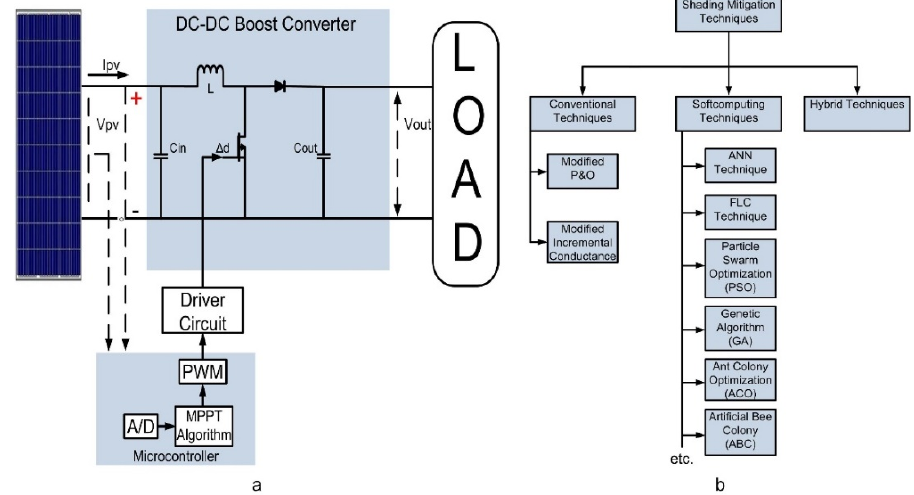
Figure 1. Solar photovoltaic system with MPPT algorithms ( a ) Basic block diagram of PV system. ( b ) Various MPPT algorithms in solar PV systems .